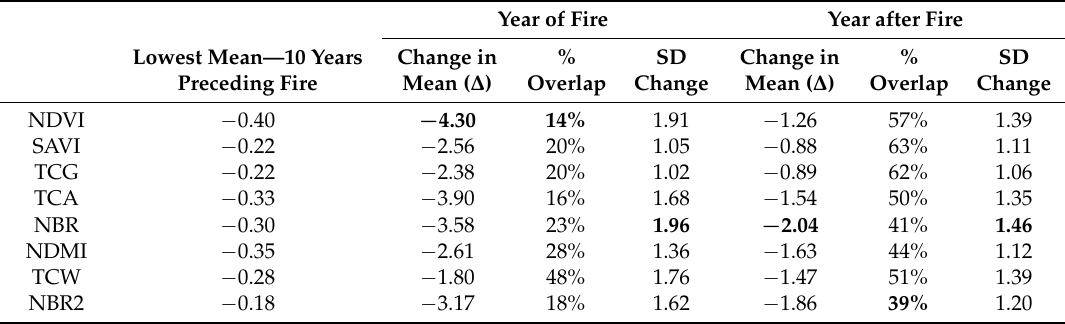
Table 4. Post-fire response of each index, shown as a standardized change in mean, percentage overlap, and relative change in standard deviation, with best results indicated in bold.